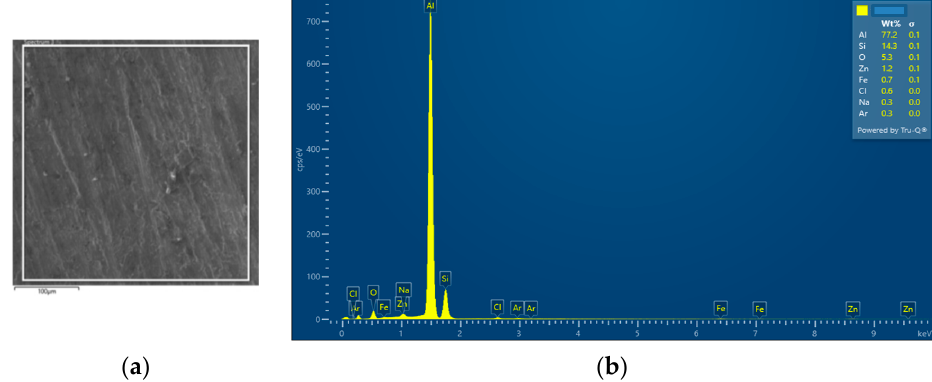
Figure 18. EDX analysis and its evaluation with respect to the local chemical composition: ( a ) chemical composition of the AlSi12 alloy used; ( b ) sample SAM6.